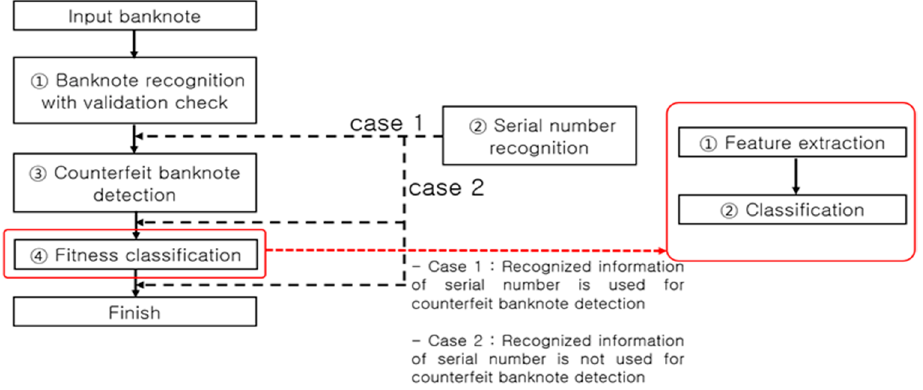
Figure 21. Process flow of fitness classification. Table 14. Studies on fitness classification by national currency (Ref.: References, A: Available, N/A: Not Available).